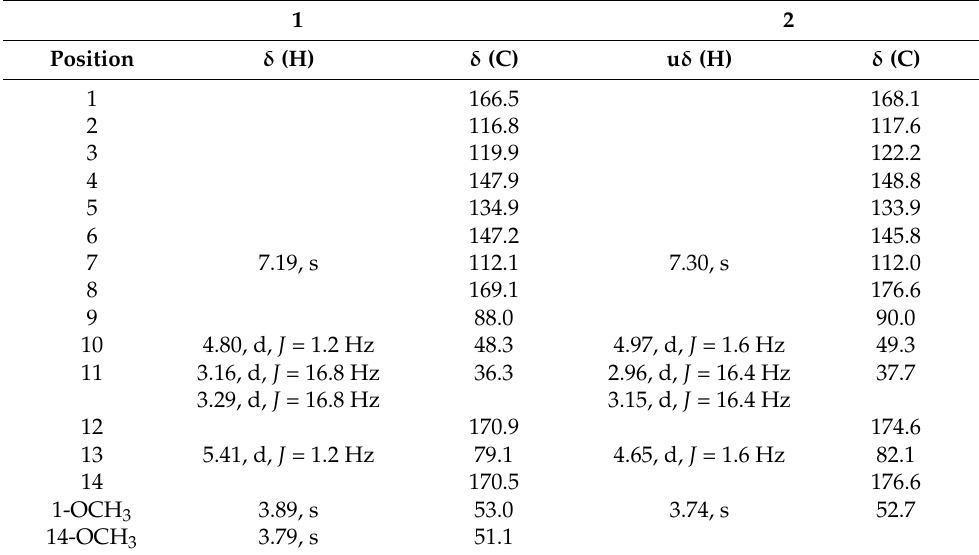
Table 1. 1 H-NMR and 13 C-NMR spectral data for compounds 1 and 2 ( 1 in CD 3 OD and 2 in D 2 O) a